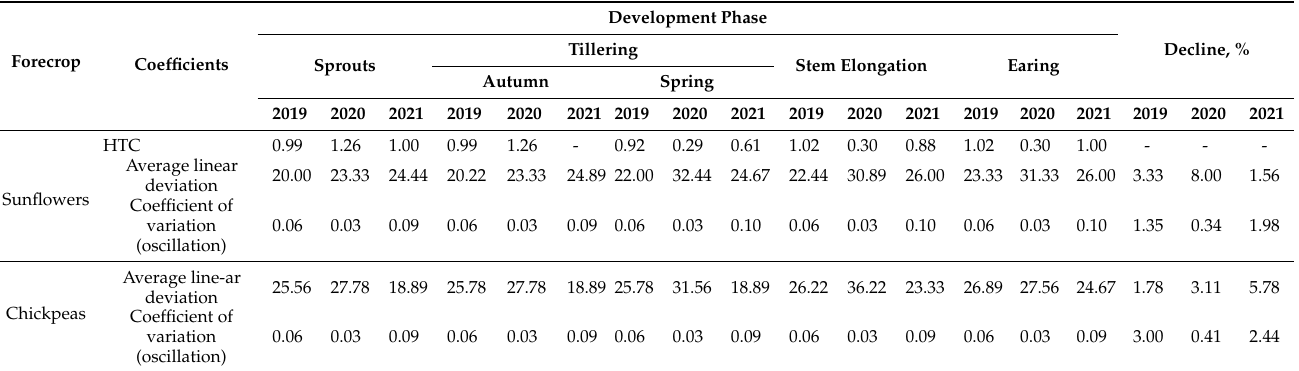
Table 6. Plant density of winter wheat,